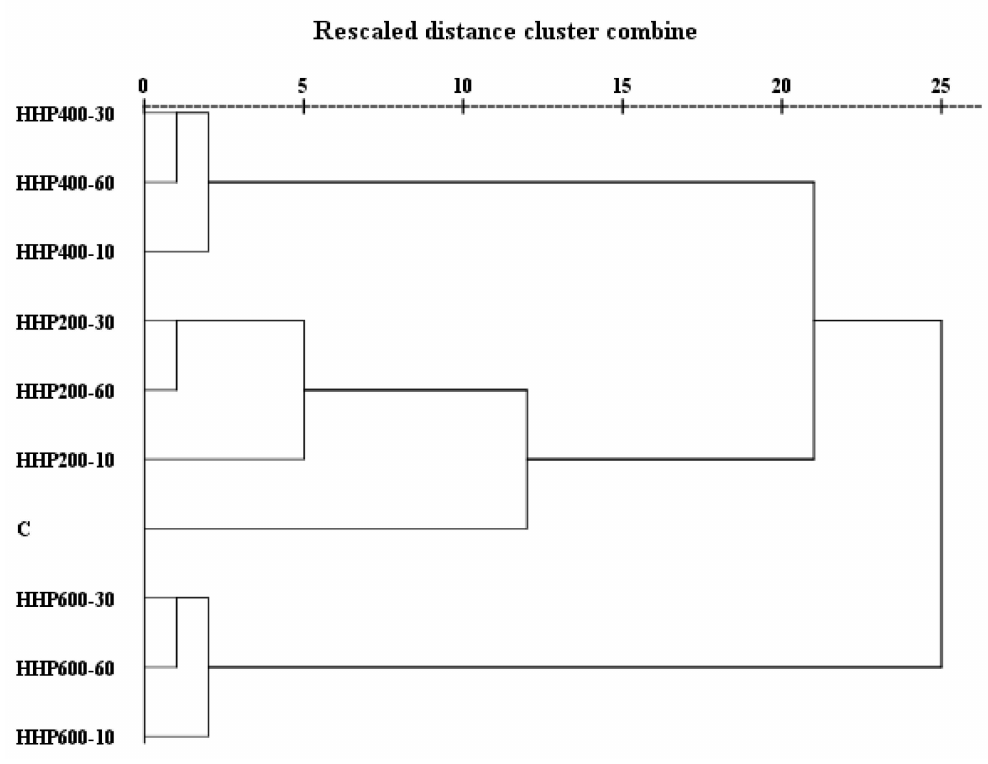
Figure 2. Hierarchical cluster analysis of the control and